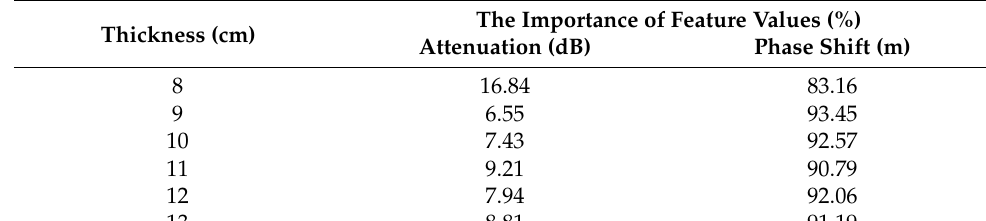
Table 1. Feature importance.